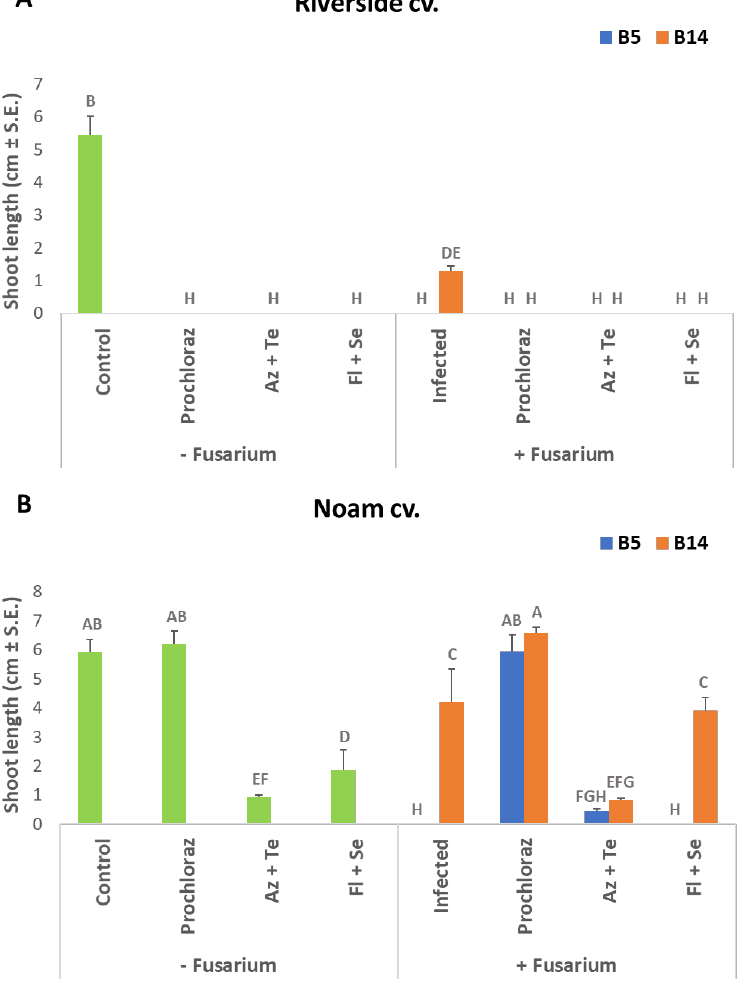
Figure 5. The stalk length of the onion genotypes Riverside ( A , Orlando) and Noam ( B ) under the influence of selected fungicides and Fusarium spp. inoculation. The experiment description and abbreviations are detailed in Figure 4. The columns represent an average of five repetitions, deviation lines represent a standard error. Different letters above the columns represent a significant difference ( p < 0.05) in the ANOVA test.